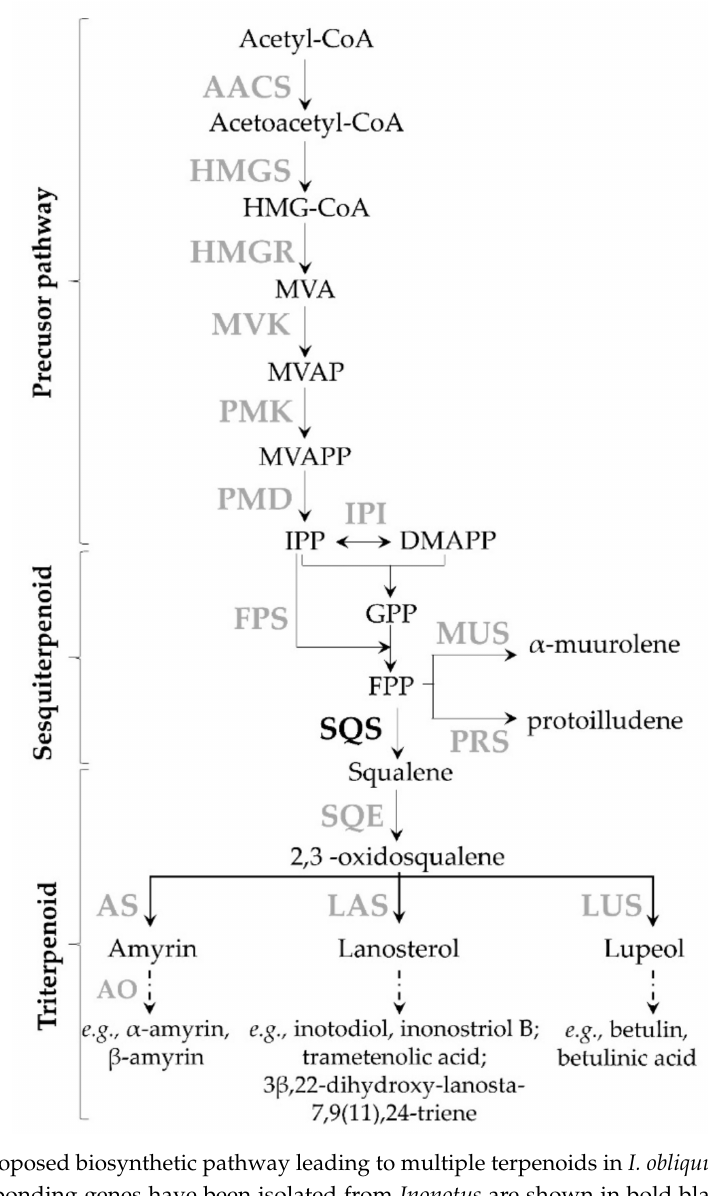
Figure A1. Proposed biosynthetic pathway leading to multiple terpenoids in I. obliquus . Enzymes for which corresponding genes have been isolated from Inonotus are shown in bold black whereas the ones from other species are shown in bold grey. Broken arrow represents more than one biochemical reaction. Abbreviations: HMG-CoA, 3-hydroxy-3-methylglutaryl-CoA; MVA, mevalonic acid; MVAP, MVA phosphate; MVAPP, MVA diphosphate; IPP, isopentenyl diphosphate; DMAPP, dimethylallyl diphosphate; GPP, geranyl diphosphate; FPP, farnesyl diphosphate; AACT, Acetoacetyl-CoA transferase; HMGS, HMG-CoA synthase; HMGR, HMG-CoA reductase; MVK, MVA kinase; PMK, phosphoMVA kinase; PMD, diphosphoMVA decarboxylase; IPI, IPP isomerase; FPS, FPP synthase; MUS, Muurolene synthase; PRS, Protoilludene synthase; SQS, Squalene synthase; SQE, Squalene epoxidase; AS, Amyrin synthase; β AO, 11-oxo- β -amyrin 30-oxidase; LAS, Lanosterol synthase; LUS, Lupeol